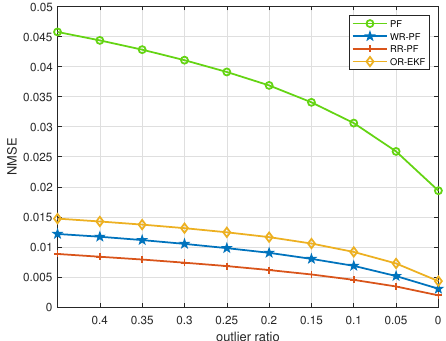
Figure 4. Estimated NMSE versus outlier ratios.